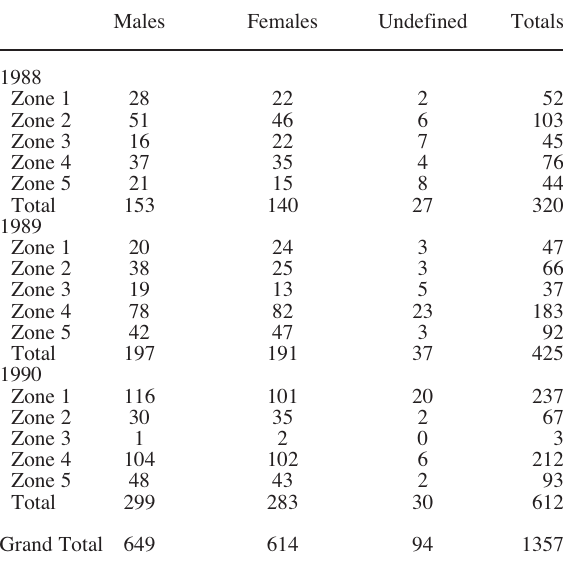
T ABLE 2. – Number of individuals of Microphrys bicornutus col- lected within quadrates in each of the sampling zones during the period 1988-1990, in Buchuaco (Venezuela).